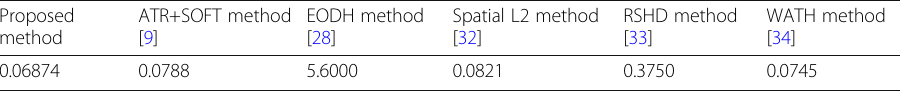
Table 7 Computational time (in seconds) of the proposed method as compared to competitive CBIR